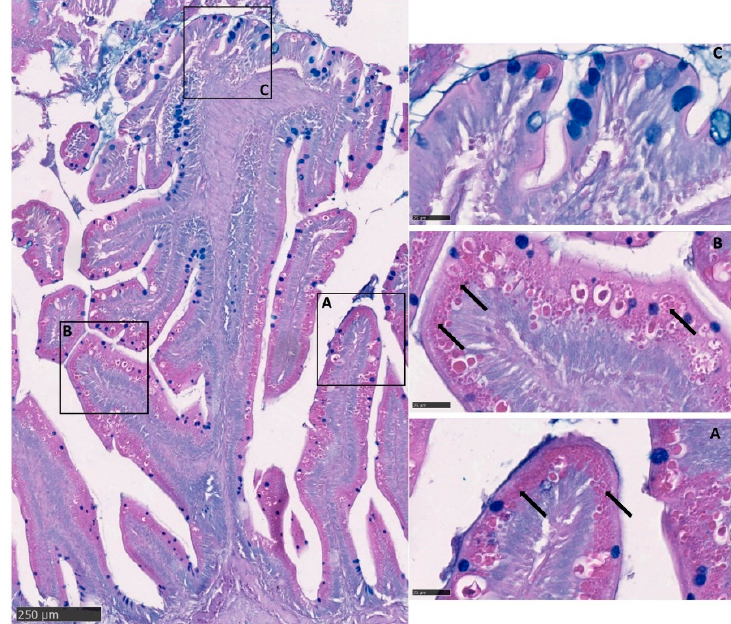
Figure 7. Alcian Blue–Periodic acid–Schiff (AB-PAS) stained section showing the presence of numerous PAS-positive pinocytotic vacuoles (arrows) on the villi of the distal intestine ( A ), as well as, on the basal part of the complex folds ( B ); whereas, they were completely absent at the fold apex ( C ).